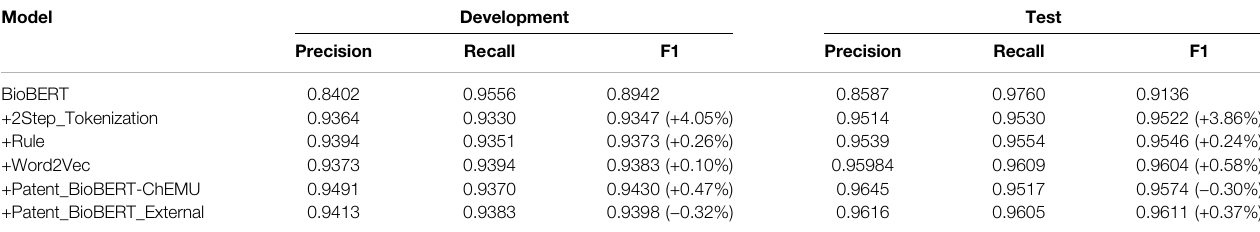
TABLE 6 | Performances of semantic role recognition by adding different strategies incrementally. Exact matching results of the development and test data using the fi ne- tuning method are reported.